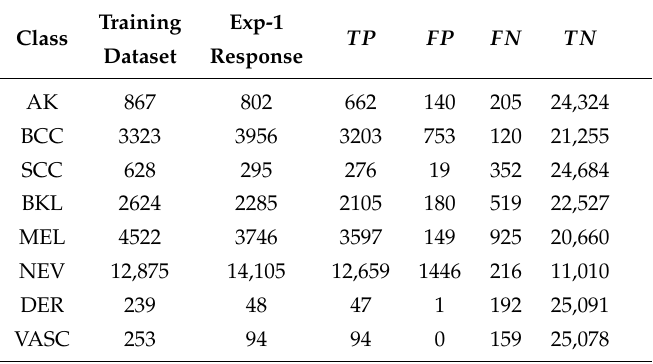
Table 3. Performance of the Exp-1 based on the confusion matrix in Table 2.